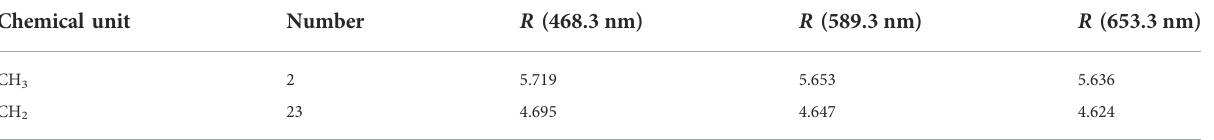
TABLE 2 Chemical units used for the hydrophobic tail of a DMPC molecule. Chemical unit